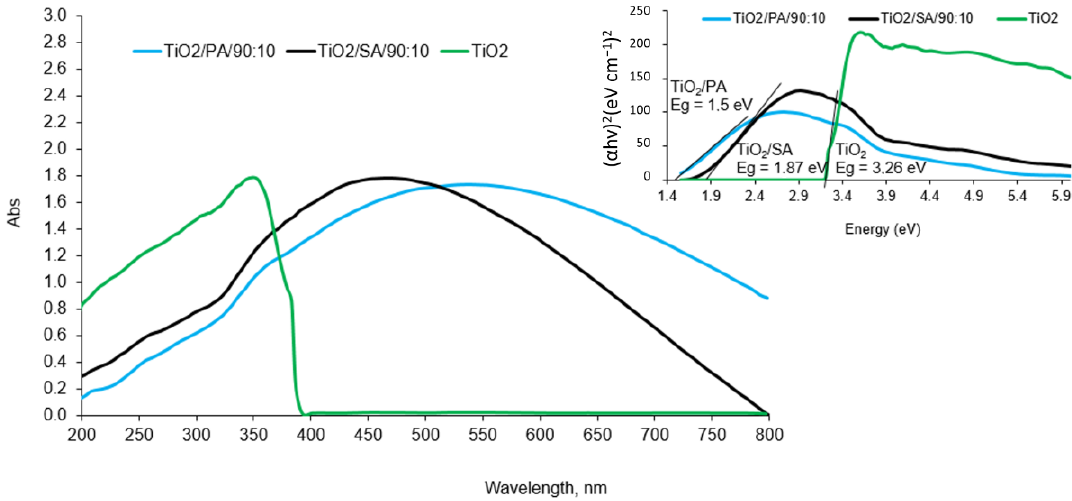
Figure 2. The UV-Vis spectra of the tested photocatalysts. Materials 2020 , 13 , 289